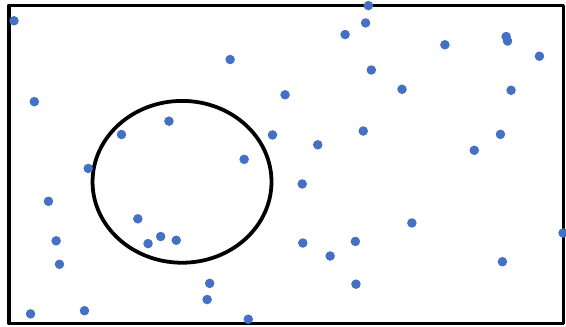
Figure 12. Distribution of graphs in a